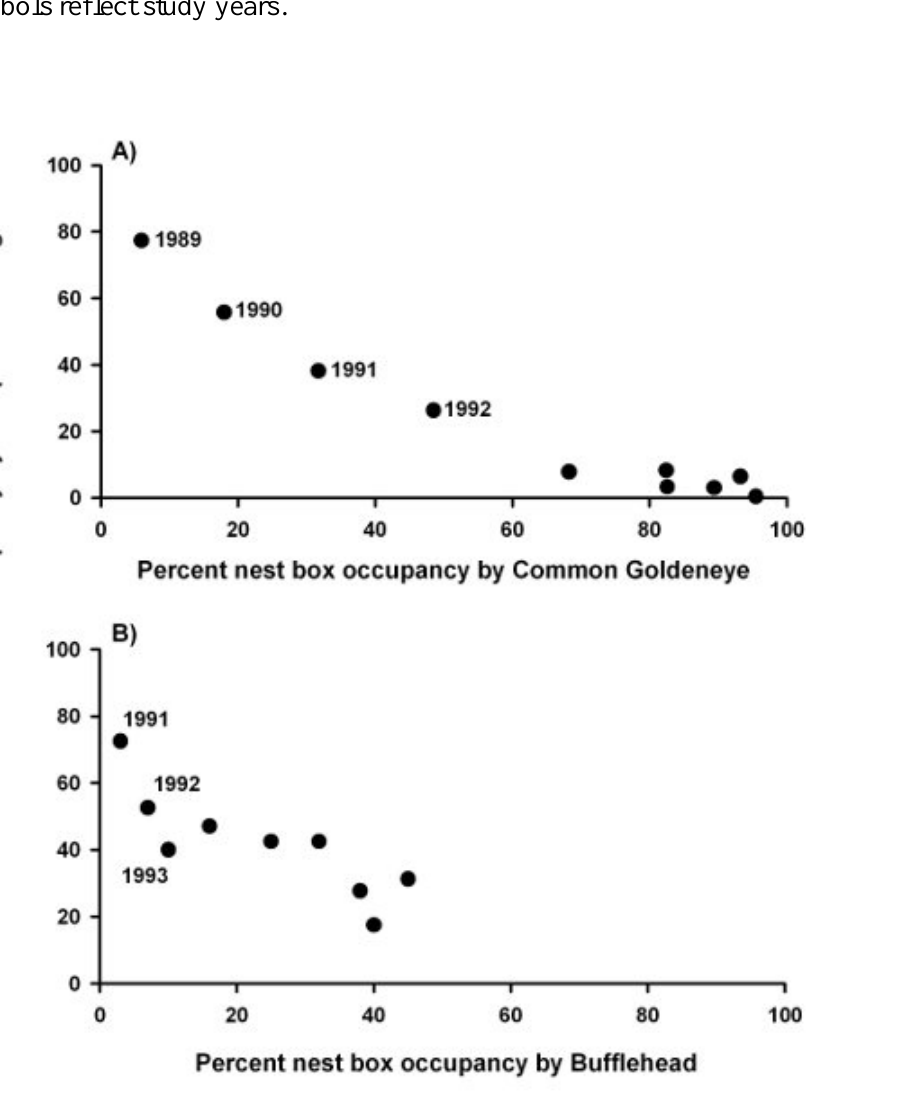
Fig. 3. Relations between occupancy of nest boxes by European Starlings, Sturnus vulgaris , and Common Goldeneye, Bucephala clangula , in large nest boxes (A) and Bufflehead, Bucephala albeola , (B) in small nest boxes deployed in the Buffalo Lake Moraine, south-central Alberta. Numbers accompanying symbols reflect study